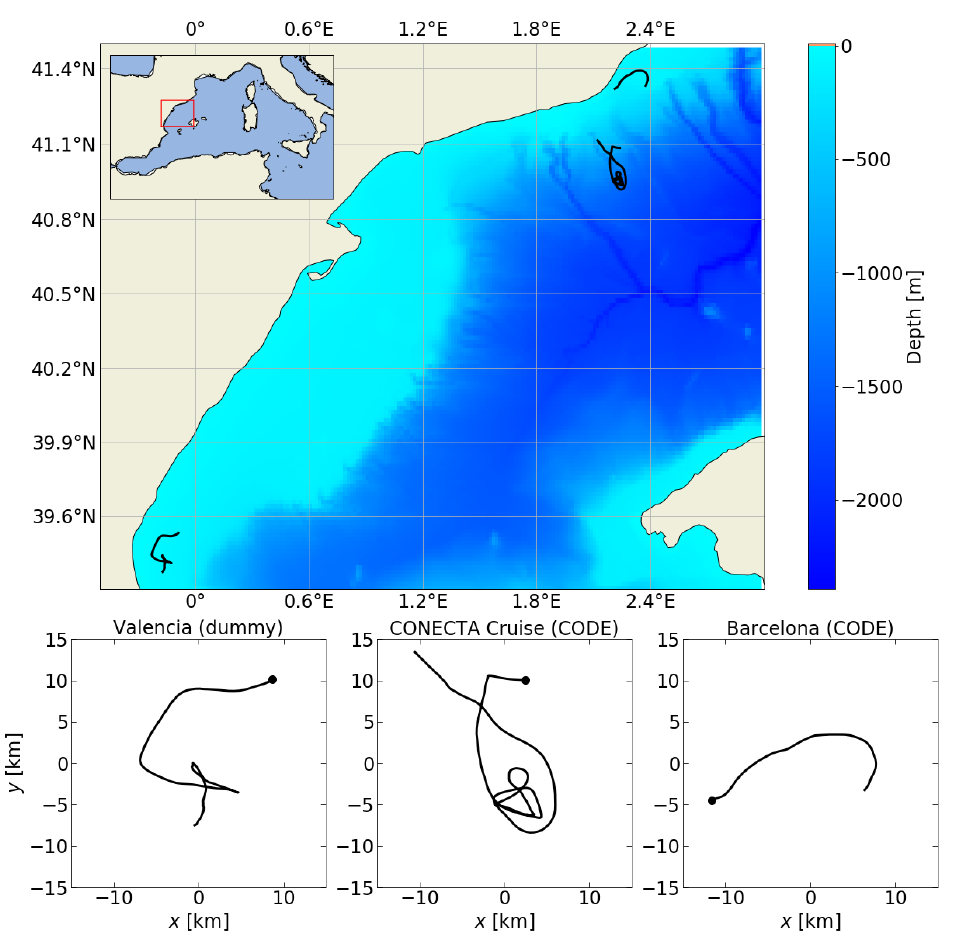
Figure 2. ( Top ): Bathymetry of the southern part of the Catalan sea showing the trajectories of surface drifting buoys used in this study and the location of the area of study in the western Mediterranean Sea. ( Bottom ): Zoom of drifter trajectories with the drifter type and their size. The solid black line corresponds to the observed trajectory and the dot its initial position. From ( left ) to ( right ): Trajectory of a dummy buoy in front of the Valencia coast; trajectory of the CODE drifter released during the CONECTA cruise; and trajectory of the CODE drifter released in front of the Barcelona